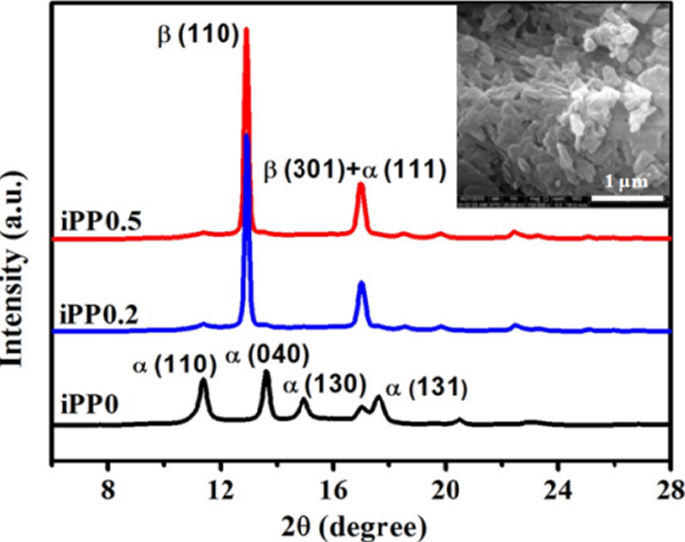
Figure 2. 1D WAXD profiles of iPP0, iPP0.2, and iPP0.5 samples crystallized under atmospheric pressure (the inset shows scanning electronic microscopy micrograph of WBG-II, supplied by the provider).